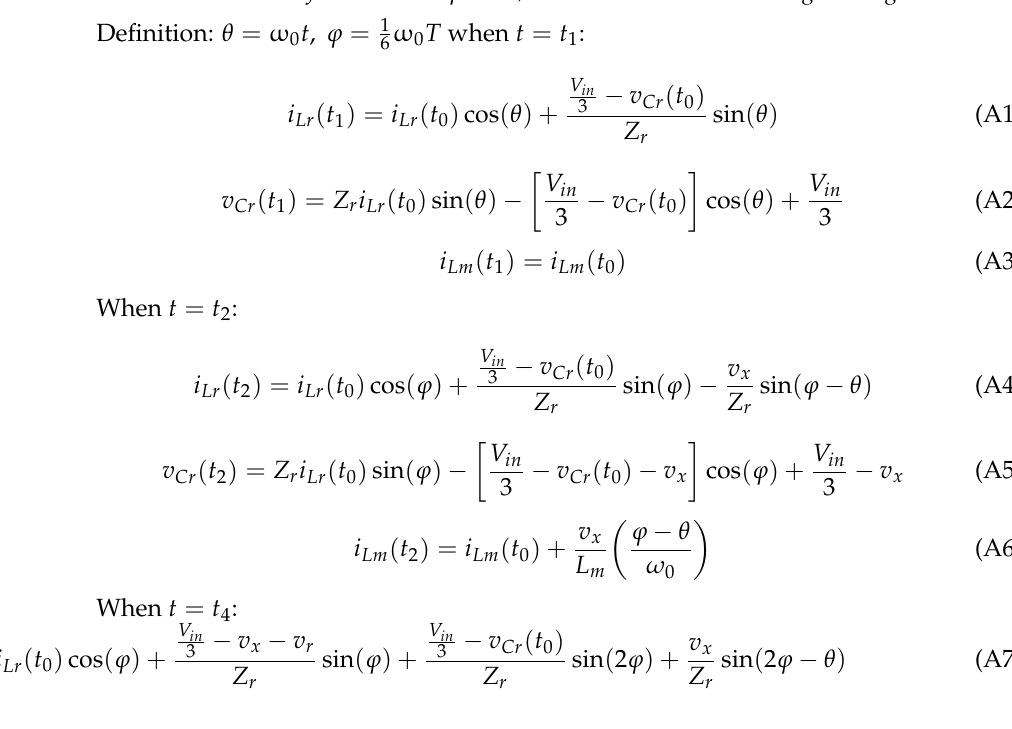
Figure 25. Three-phase wye–delta LLC prototype.